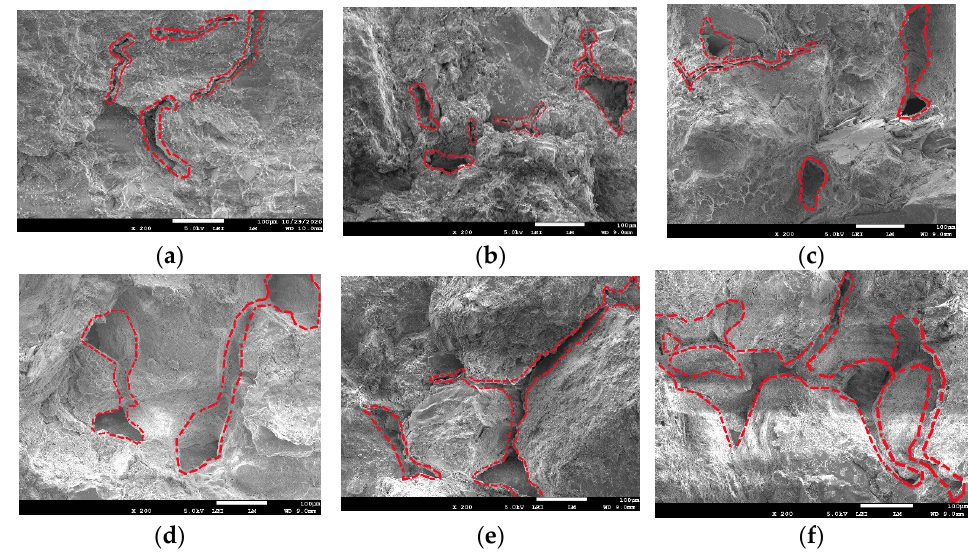
Figure 7. SEM images of specimen at different freeze–thaw cycles ( × 200 times). ( a ) N = 0, ( b ) N = 1, ( c ) N = 3, ( d ) N = 6, ( e ) N = 9, ( f ) N = 12.